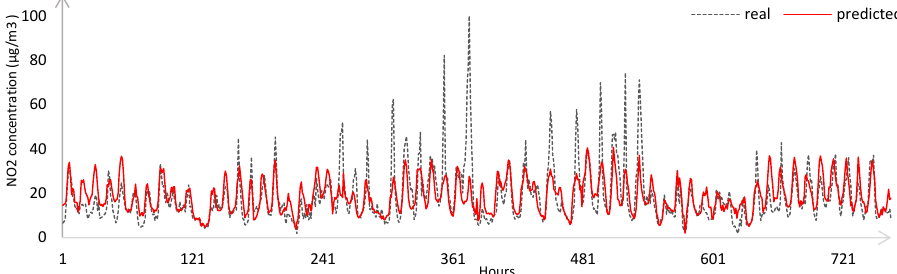
Figure 12. Real and predicted NO 2 , Sensor DETH020, September 2019, horizon: 120 h.